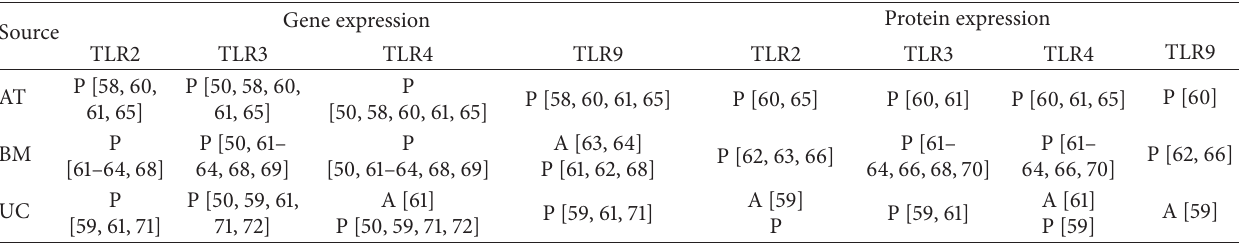
Table 2: Gene and protein expression of Toll-like receptors MSCs from different sources. Gene expression Protein Source